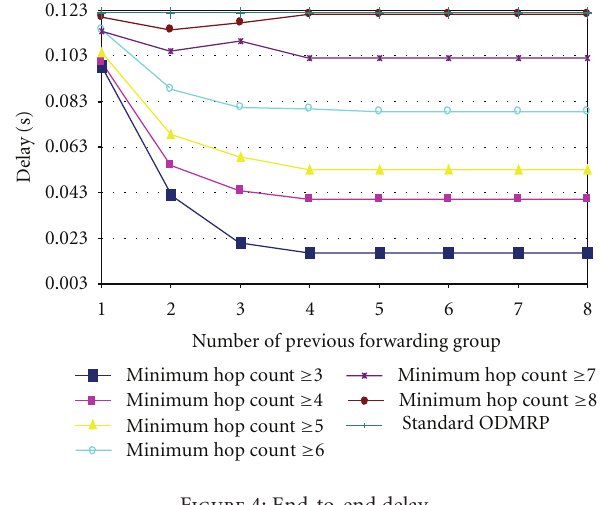
Figure 4: End-to-end delay.